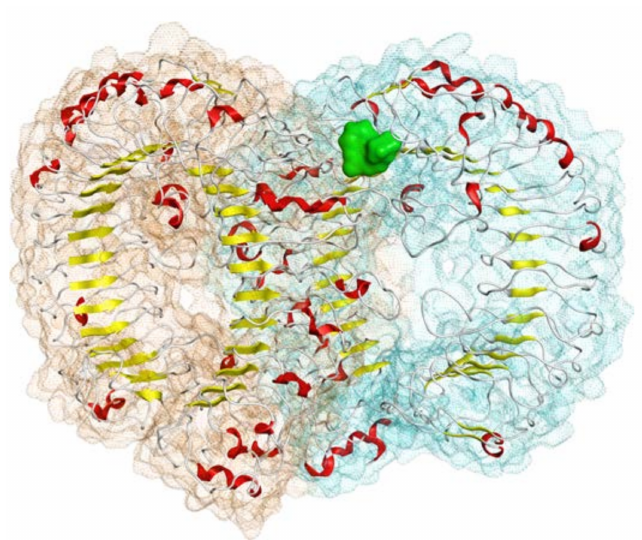
Figure 2. Structure of the homodimeric model of the TLR7 ectodomains obtained in our previous work from the TLR8 template. The a and b monomer surfaces are represented in brown and cyan, respectively. Each monomer secondary structures are colored as follow: helices in red, strands in yellow, loops and turns in white. The R-837 binding site targeted in this study, lying at the interface of the two monomers, is represented as green